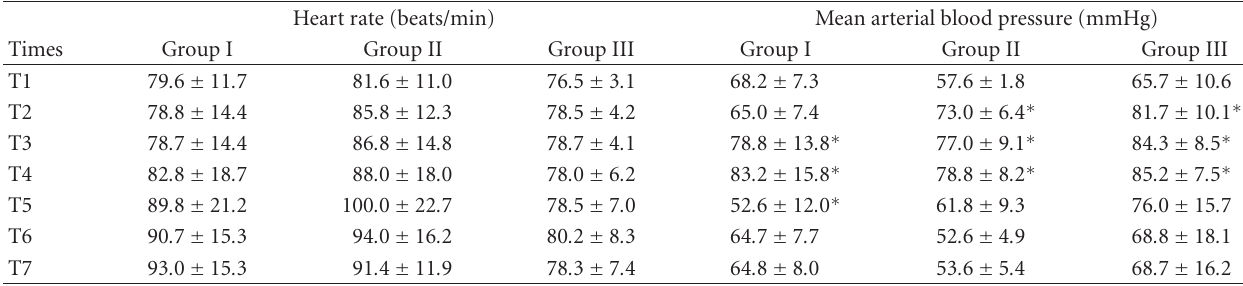
Table 1: Heart rate and mean arterial blood pressure in pigs anesthetized with sevoflurane, fentanyl, and vecuronium and undergoing aortic cross-clamping through laparotomy (Group I) or laparoscopy with (Group II) or without aortic cross-clamping (Group III).